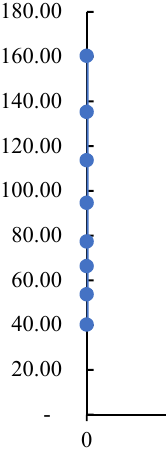
Figure 7. Profiles of carbon emissions under BAU and carbon mitigation scenarios. (Scenario 1: Ban on oil use in power generation, Scenario 2: CO 2 price $7.3/tonne that rises 5% annually, Scenario 3: CO 2 cap by 15% of Scenario 1 by 2030 combined with a ban on oil in power generation). 4.4. Investments Requirements Figures 8–10 show estimation of the investments requirements for Scenarios 1, 2 & 3. It is found that Scenario 1 offers a cheaper alternative to conventional technologies, Figure 8, as energy demand increases from 2020 to 2050. In this scenario, electricity is assumed to be mainly generated via underground oil gasification combined with solid oxide fuel cell, while the road transport sector remains dependent on conventional gasoline and diesel. On the other hand, the investment requirements for Scenario 2 are significantly higher than the BAU case, Figure 9. It is found that total investments rise from around $20 billion, in 2020, to more than $60 billion, in 2050, in Scenario 2, while the BAU case rises from nearly $7 billion, in 2020, to $22 billion in 2050. This significant increase in the cost observed in Scenario 2 is due to the use of the thermal splitting and PEM fuel cell technology which accounts for at least 75% of total investment requirements. The investment requirements for Scenario 3, Figure 10, are only cheaper at the initial stage of transition between 2020– 2030, below $7 billion, but they tend to become at a greater cost compared with conventional technologies as energy demand rises between 2035 and 2050, reaching nearly $30 billion. This is due to the supply of methanol, obtained from fuel oil gasification, in road transport, and the use of thermal splitting with PEM fuel cells in power generation.